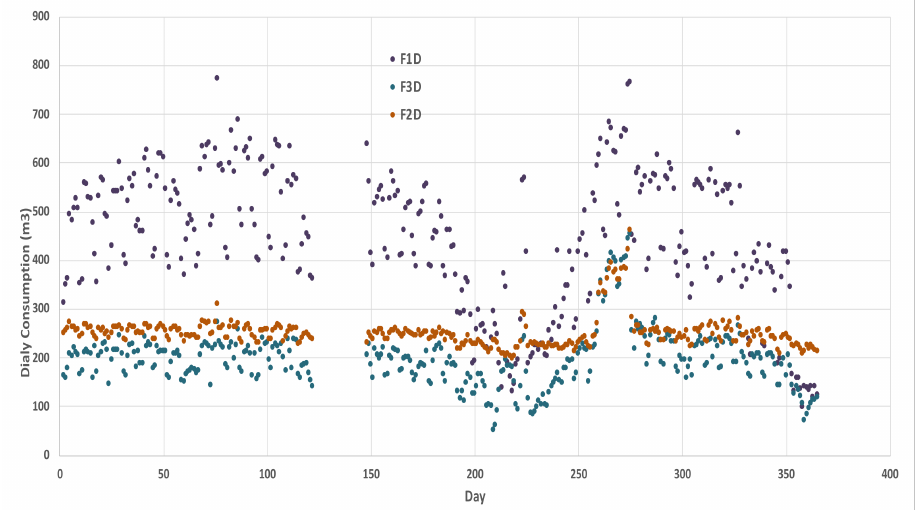
Figure 17. Variations in the repartition of the daily water supply on the scientific campus in